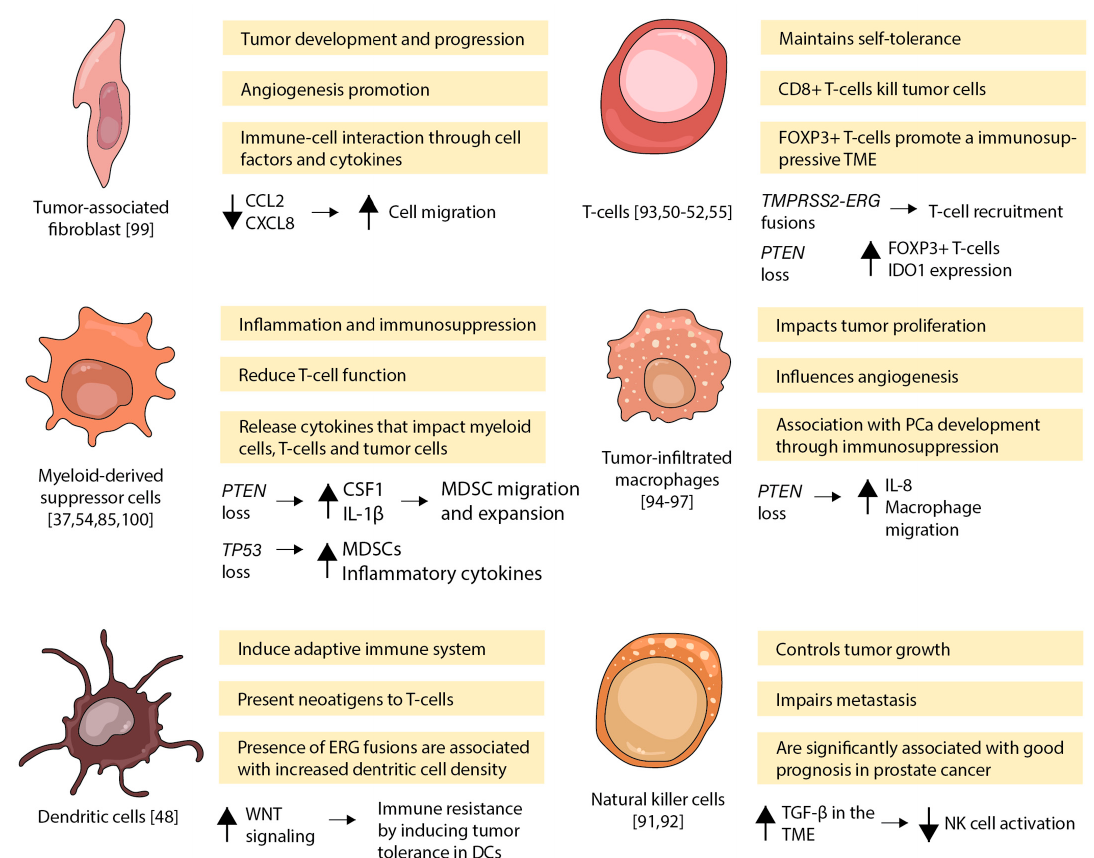
Figure 2. Mutation and gene expression changes leading to cellular and immune evasion effects in the TME of PCa. The various somatic mutations can influence the non-cancerous cell in the tumor microenvironment of prostate cancer. CCL2 (C-C Motif Chemokine Ligand 2), CD8+ T cell (cytotoxic T lymphocyte), CSF1 (colony Stimulating Factor 1), CXCL8 (C-X-C Motif Chemokine Ligand 8), DC (dendritic cells), ERG (ETS Transcription Factor ERG), FoxP3+ (Forkhead box p3), FoxP3+ T cell (regulatory T lymphocyte), IDO1 (indoleamine 2,3-Dioxygenase 1), IL-1 β (interleukin 1, beta), IL-8 (interleu- kin 8), MDSC (myeloid-derived suppressor cell), NK (natural killer cell), PTEN (phosphatase and tensin homologue), TGF β (transforming growth factor beta), TME (tumor microenvironment), TMPRSS2 (Transmembrane Serine Protease 2), TP53 (Protein Coding), WNT (important pathway for immune cell maintenance and renewal). Up arrows (increase). Down arrows (decrease) [37,48,50–52,54,55,85,91–99,100].